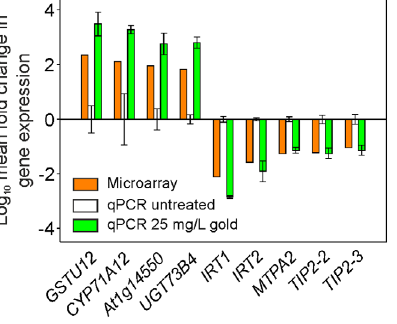
Figure 4. Relative fold induction of gene expression in Arabidopsis root tissue treated with gold. Plants were grown hydroponically for six weeks then the medium was replaced with 25 or 50 mg/L gold, as K(AuCl 4 ) for 6 h, and then RNA extracted from roots for qPCR analysis. The data were normalized to the Arabidopsis ACTIN2 gene and relative fold induction calculated using the DD Ct method [36]. Results are the mean from four biological replicates 6 SD, * denotes significantly ( p , 0.05) more upregulated than untreated samples.